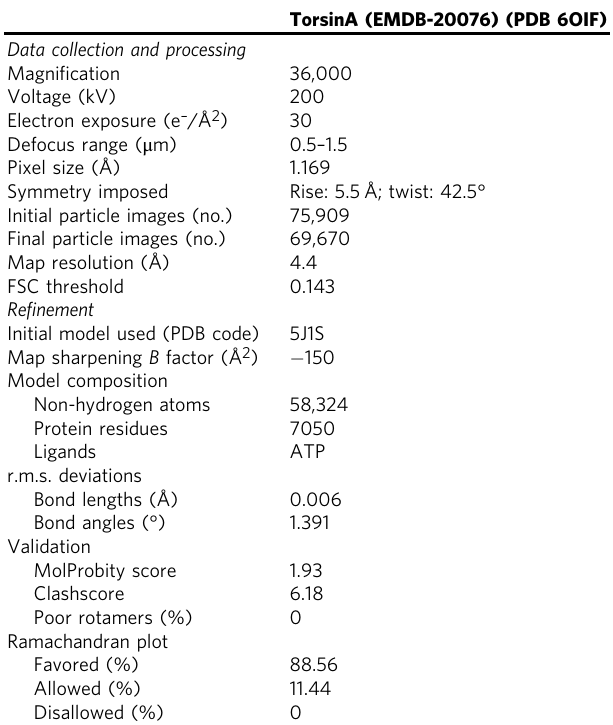
TorsinA (EMDB-20076) (PDB 6OIF)